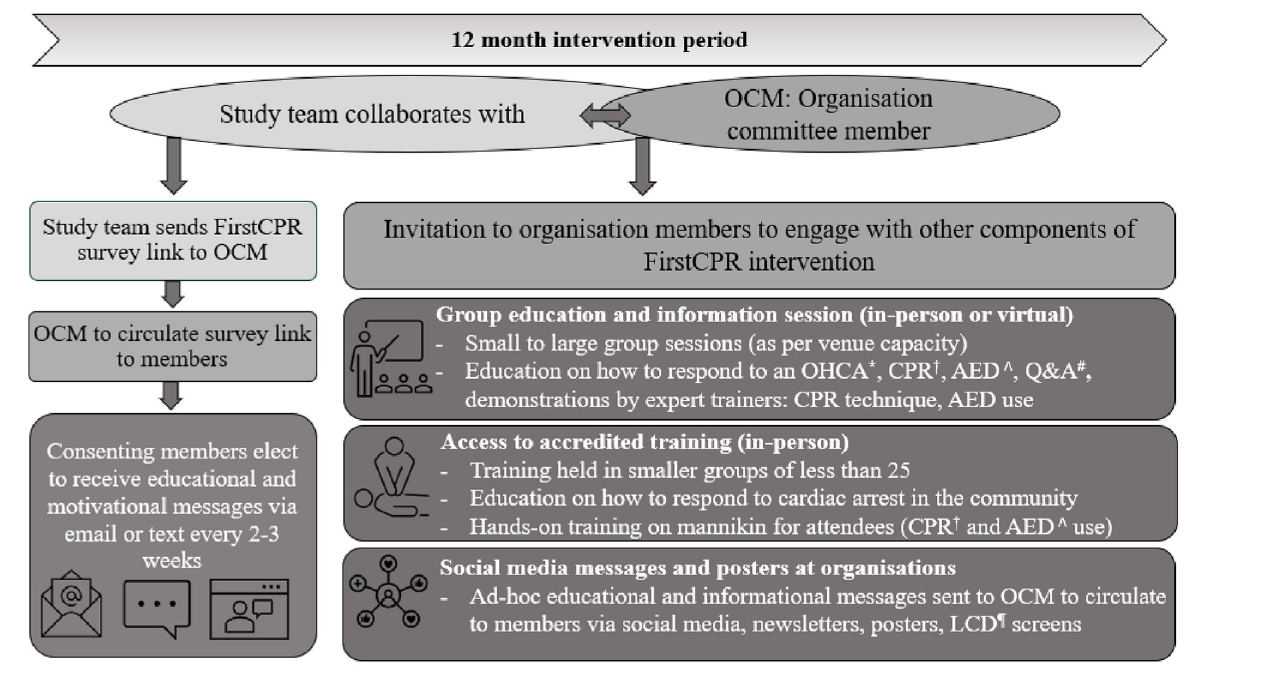
Fig 4. Multicomponent intervention (digital and in-person format) with delivery plan to individuals and groups.